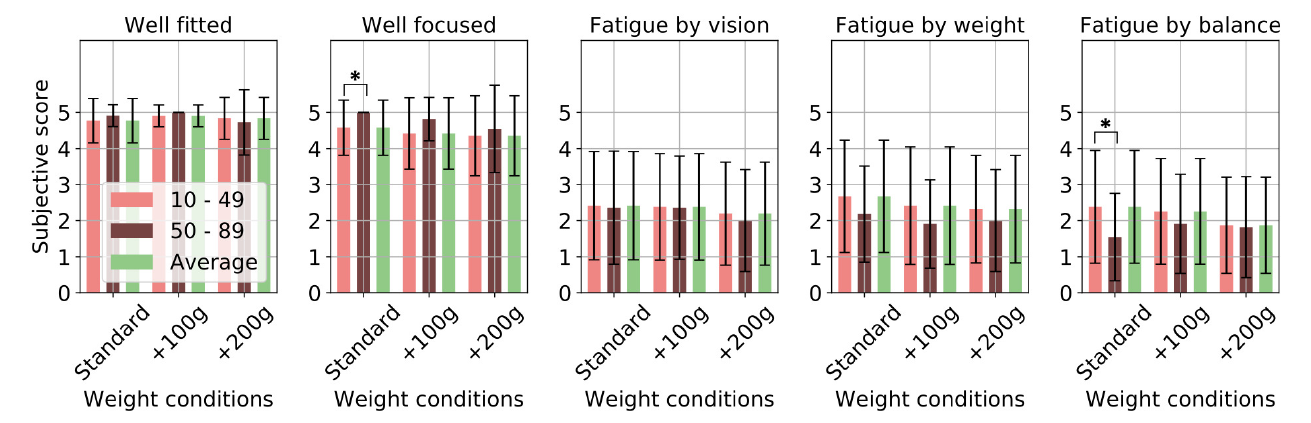
Figure 9. Questionnaire results for female participants in the “rear” group. The results of Q1 to Q5 are shown from left to right. (*: p < 0.05).